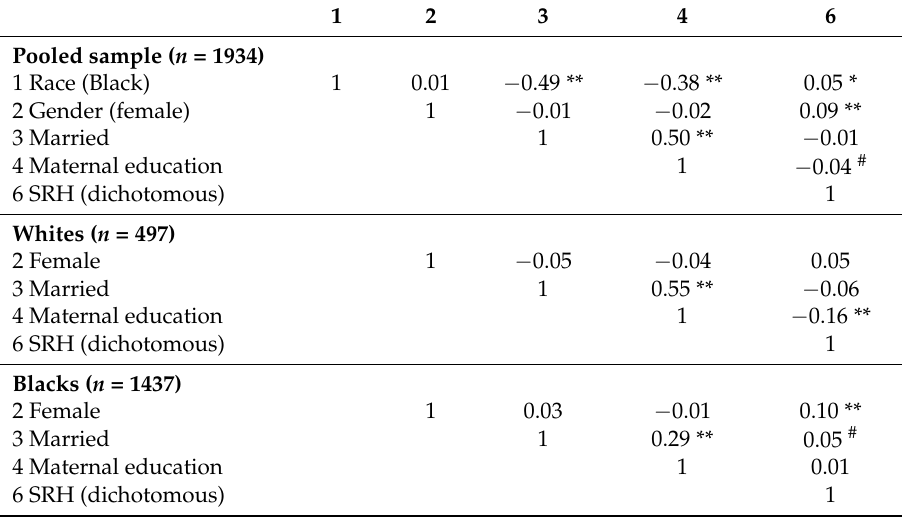
Table 2. Correlations between study variables in the pooled sample and across races.